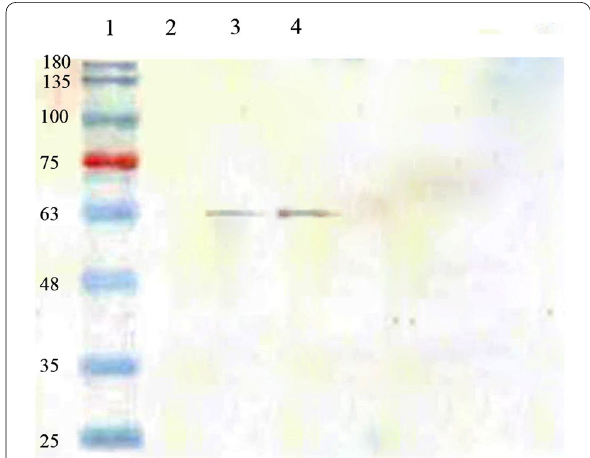
Fig. 7 The result of western blotting to increase the sensitivity in the detection of membrane proteins. Lane 1: marker weight (#SL7001-Sinaclon, Iran). Lane 2: pre-induced protein without expression. Lane 3: a positive control sample, a positive western bloat response to a His-Tag protein sample weighing 63 kD. Lane 4: confirmation of recombinant HN protein (63KD) expression, 8 h after induction. Lane 5: lack of recombinant protein secretion in bacterial cells containing plasmid without HN